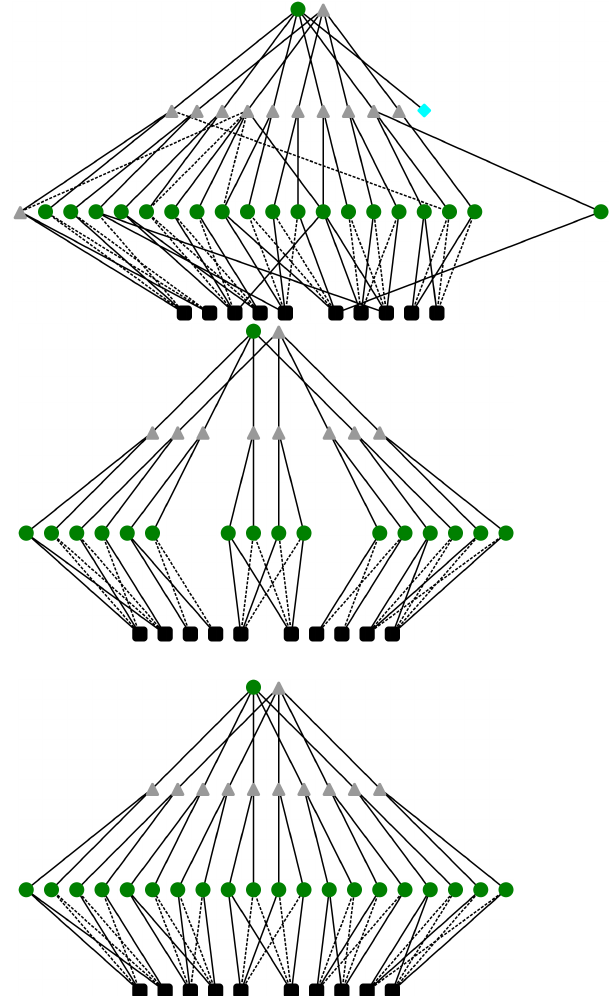
Figure 10. Comparison of L-neuron structures in a purely knowledge-based model for 0.05 im- pairment and the 1024 element dataset. Dashed lines indicate complemented connection, while continuous lines depict passthrough connections (neutralizing connections are skipped for the sake of clarity). Circular green nodes indicate dominance of logical AND ( α → 1), whereas triangular grey nodes indicate dominance of OR ( α → 0). Black squares designate inputs, while the blue rhombus indicates an L-neuron with no inputs. Neurons in each layer are drawn in the same order in all graphs. Neurons that do not influence the output value are removed to further improve readability. The inputs are placed in a paired order (1, 11, 2, 10, 3, 4 (not shown), 9, 5, 8, 6, 7) in order to increase readability. ( Top ) Initial, impaired rule layout. ( Middle ) Rule layout obtained after training. ( Bottom ) A desired “perfect” rule